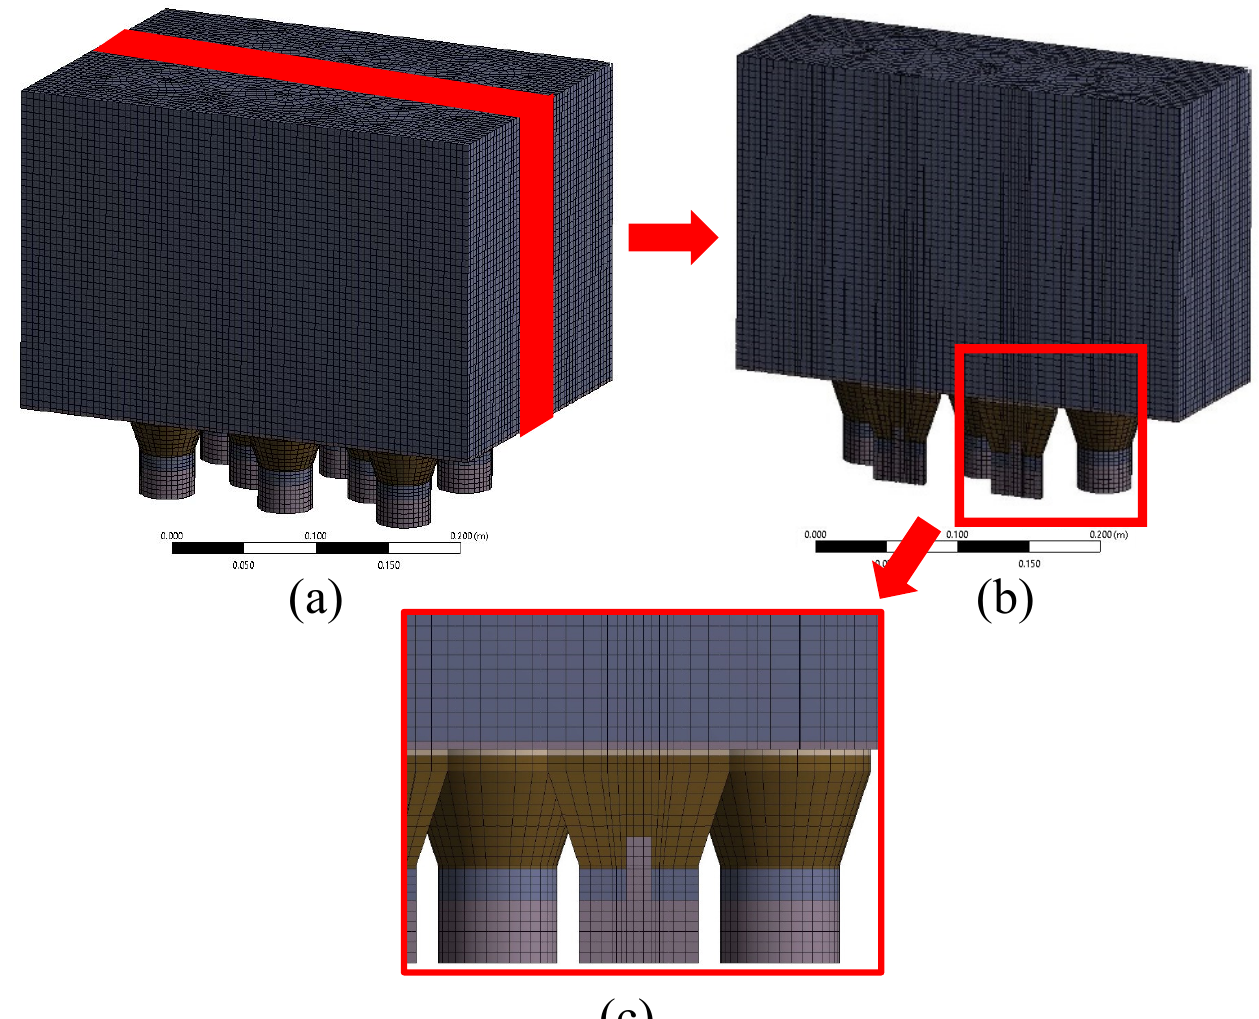
Figure 3. Mesh model ( a ) in overview, ( b ) in vertical cross section, and ( c ) around the